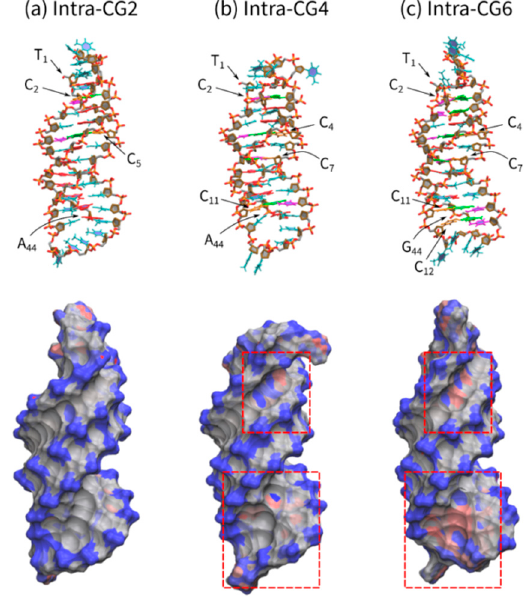
Figure 7. Triplex structures of ( a ) Intra-CG2, ( b ) Intra-CG4, and ( c ) Intra-CG6 obtained via molecular mechanics. All cytosines in the third strand are protonated. Figures in the top panel are triplex structures drawn with a stick model. Red, magenta, orange, green, and cyan sticks in the middle of the structures represent adenine, cytosine, protonated cytosine, guanine, and thymine, respectively. Orange and red sticks at the sides are phosphorus and oxygen atoms, respectively. The bottom panel figures show charge distributions. Blue, gray, and red surfaces show negative, neutral, and positive charges, respectively. The areas with a strong positive charge are highlighted with squares (red dashed line).